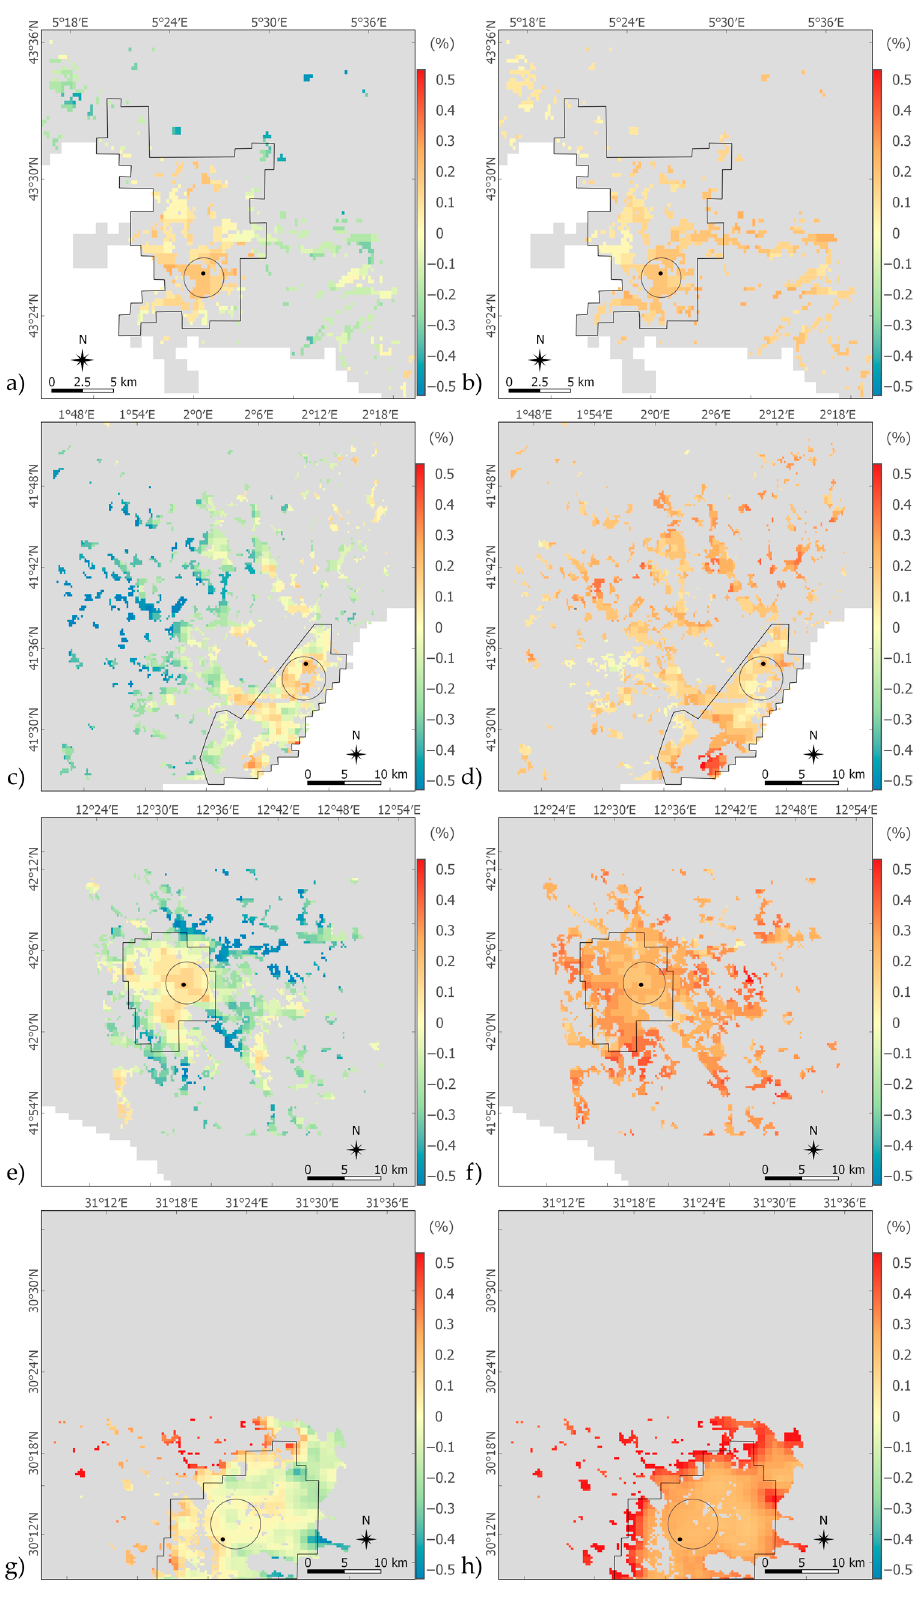
Figure 5. LST trend values of the urban pixels of a) Marseille daytime; b) Marseille nighttime; c) Barcelona daytime; d) Barcelona nighttime; e) Rome daytime; f) Rome nighttime; g) Cairo daytime and h) Cairo nighttime The solid line indicates the boundary of the urban district, the circle indicates the urban core of the city and the point indicates the pixel selected for time series analysis. (gray: outside study area and non-urban pixels, white: sea).